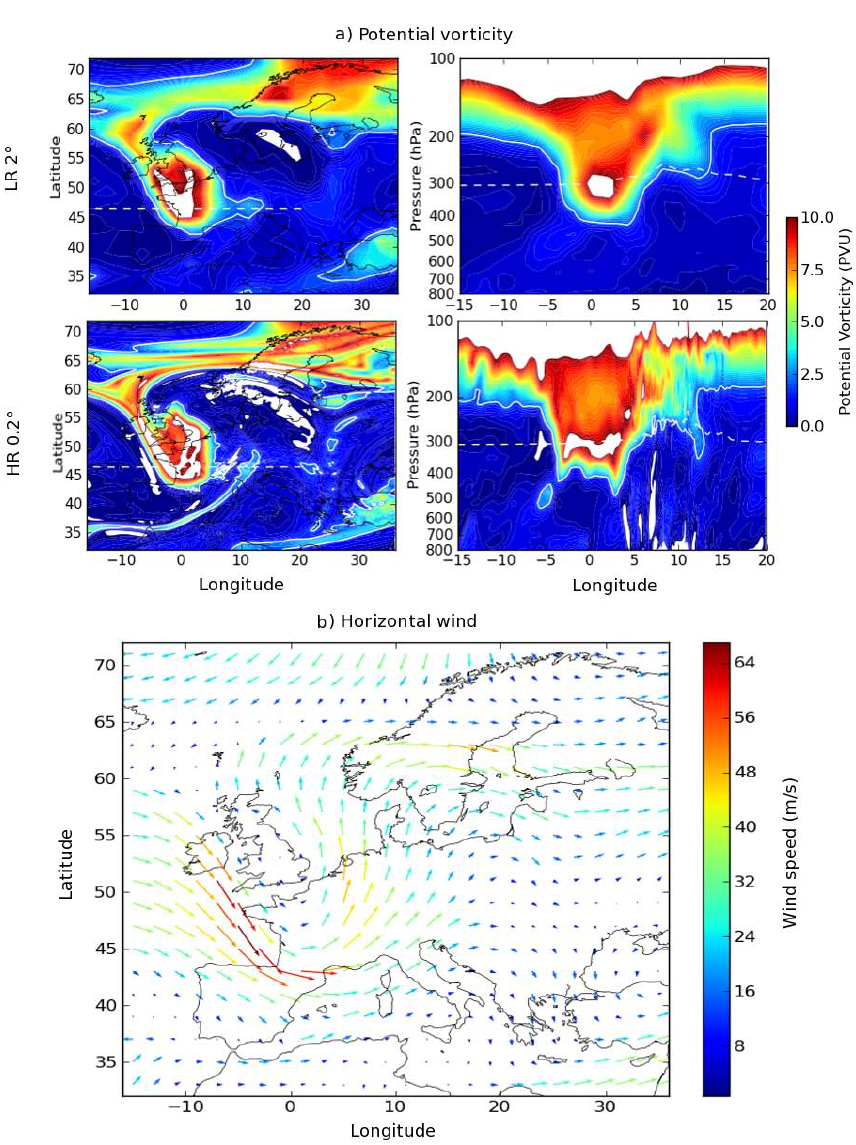
Fig. 7. Meteorological situation on 17 July 2009, 15:00UT from ARPEGE analysis. ( a) Potential vorticity fields, in potential vorticity unit (1PVU = 1 × 10 6 Kkg − 1 m 2 s − 1 ) from low horizontal resolution (2 ◦ ) simulation (top) and high horizontal resolution (0.2 ◦ ) simulation (bottom). Left hand side panels show longitude-latitude fields for a given model level; right hand side panels show longitude-pressure cross- sections. The white dashed line associates the vertical and the horizontal distribution by showing the same location between left hand side and right hand side panels. The white solid lines identify the 2PVU contour. ( b) Horizontal wind fields at LR near 300hPa.